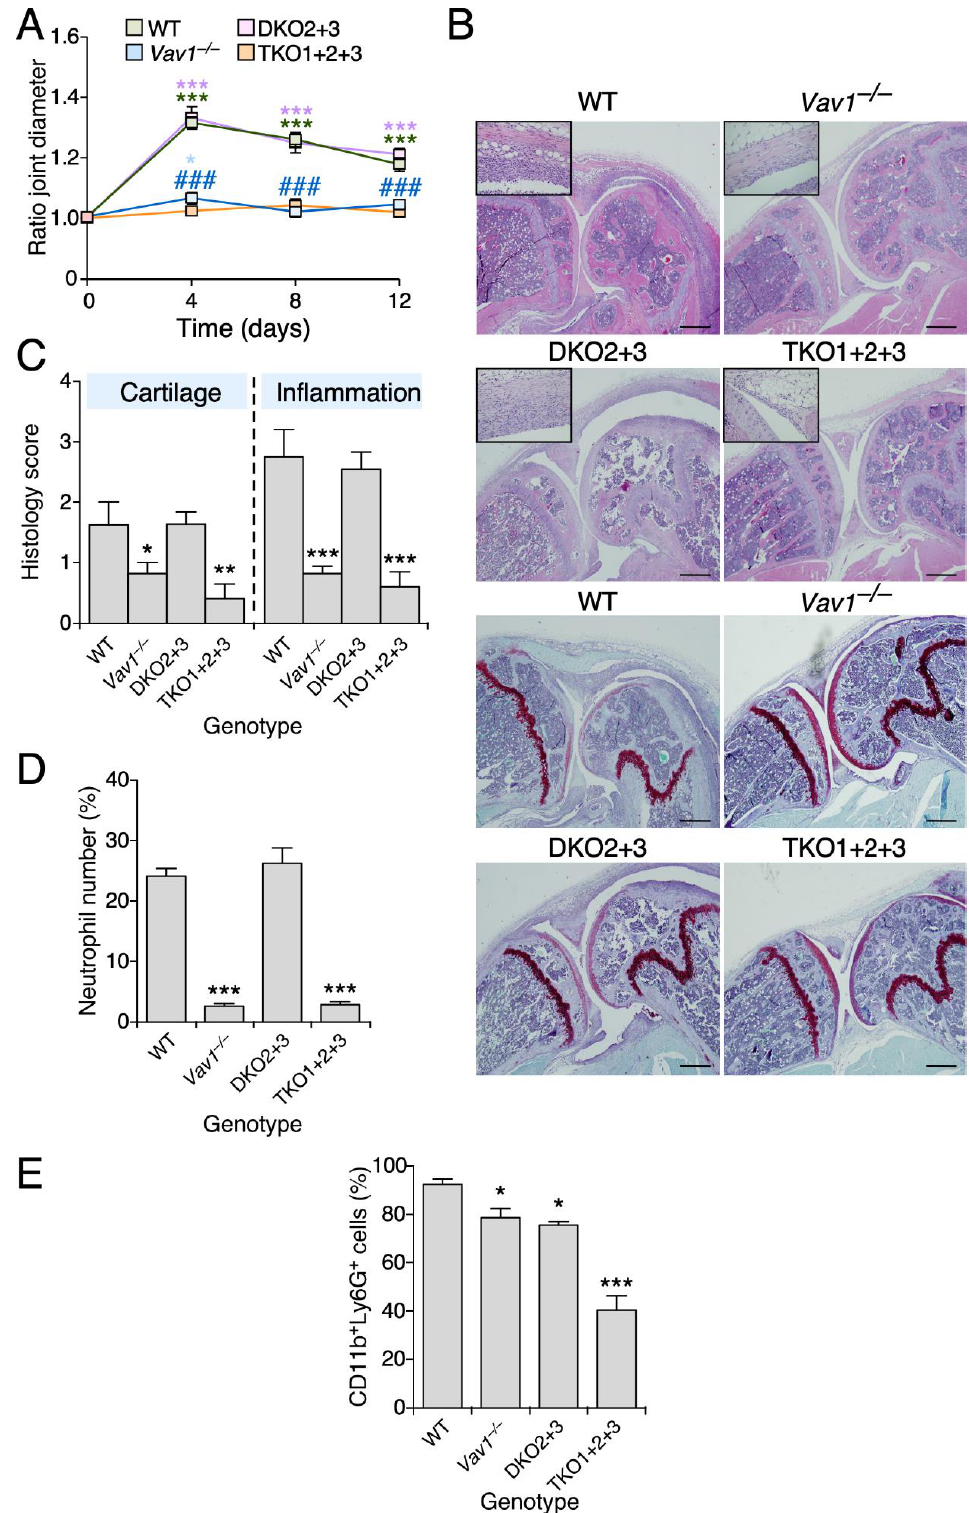
Figure 1. The Vav1 deficiency decreases the severity of antigen-induced arthritis. ( A ) Time-dependent evolution of the ratio joint diameter in animals of the indicated genotypes upon being treated with either mBSA or placebo. WT, wild-type mice; DKO2 + 3, Vav2 –/– ; Vav3 –/– mice; TKO1 + 2+3, Vav1 –/– ; Vav2 –/– ; Vav3 –/– mice. This notation has been used in the rest of the panels and figures of this work. ( B ) Representative images of histological sections from arthritic knee joints of mice